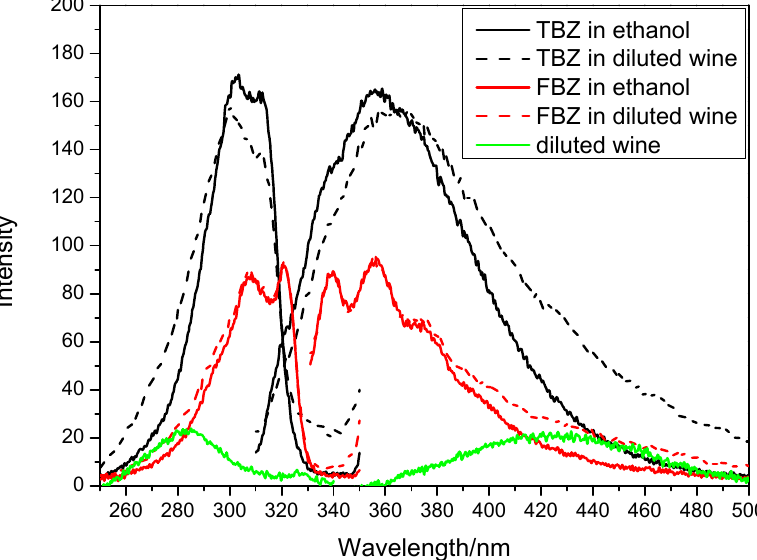
Figure 5. Excitation and emission fluorescence spectra of TBZ (300 ng/mL) and FBZ (30 ng/mL) in ethanol and diluted wine samples and diluted wine.